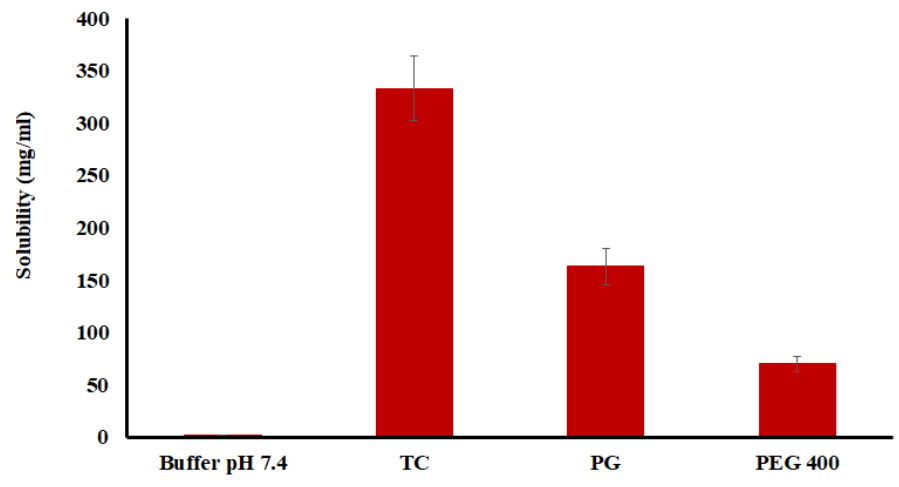
Figure 1. Solubility of desloratadine in various solvents. Data are shown as mean ± SD, n = 6. The drug has good permeation, as indicated by immediate diffusion across the syn- thetic membrane. Furthermore, the permeation was faster through the pig skin compared to the synthetic membrane. The flux (J) value was 4.99 and 6.54 μg/cm 2 .h, respectively